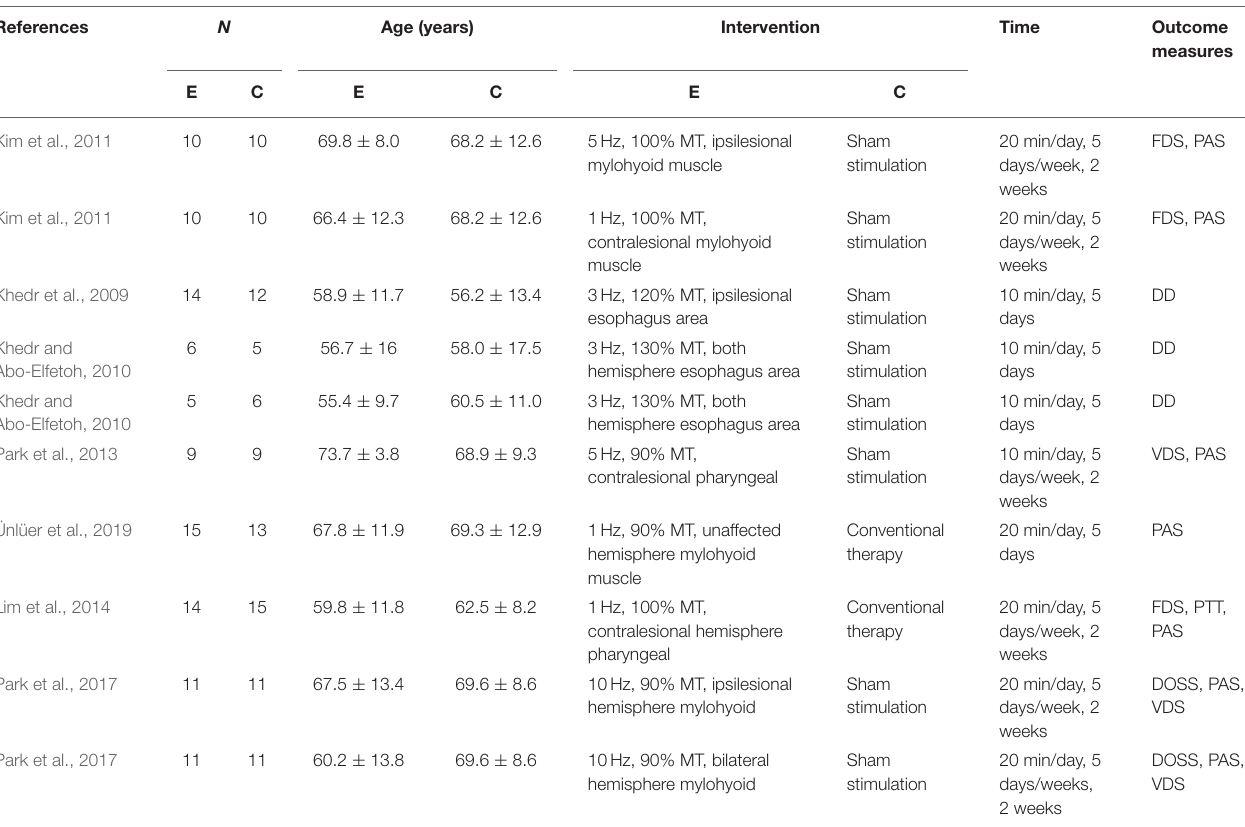
TABLE 1 | Characteristics of the randomized controlled